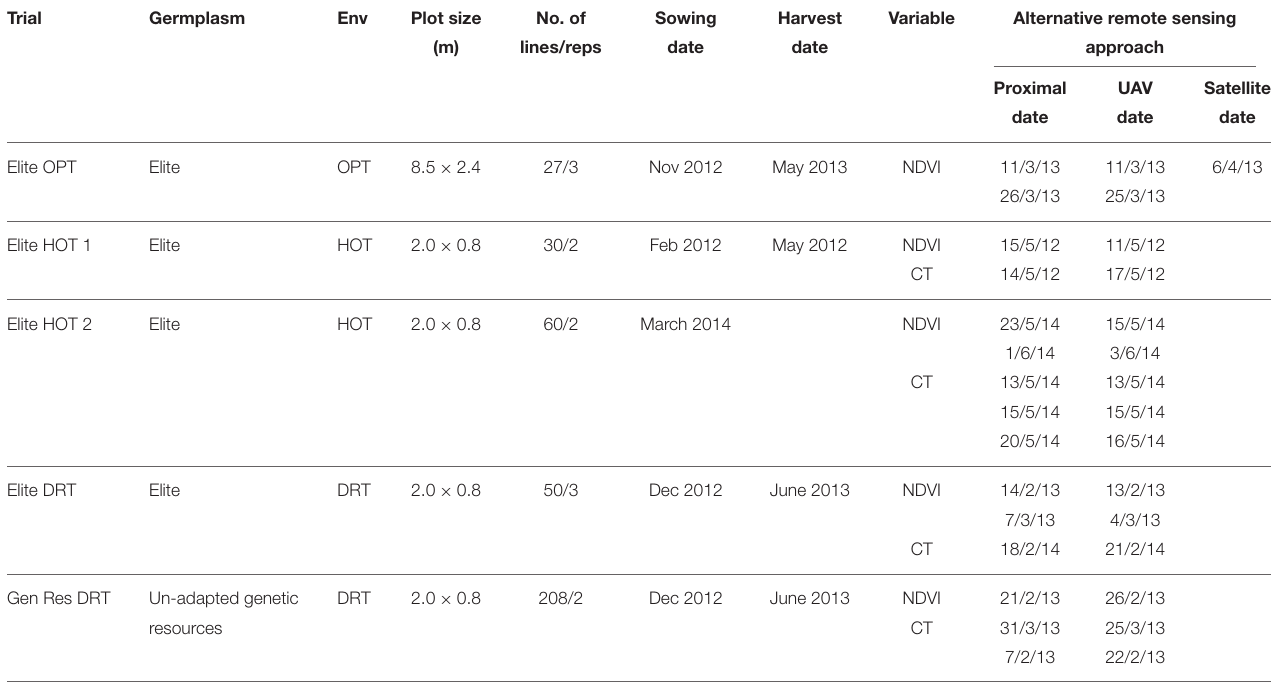
TABLE 1 | Details of the five trials under the three environments of DRT (drought), OPT (irrigated) and HOT (hot irrigated). Trial Germplasm